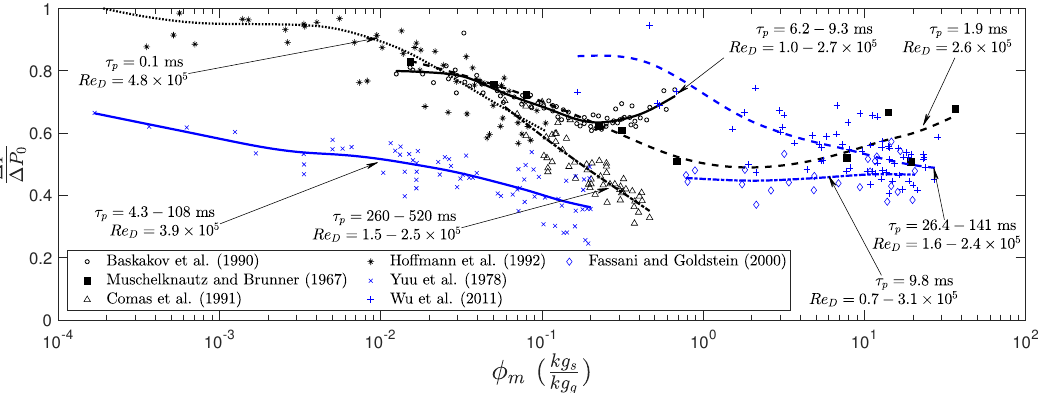
Figure 3. Experimental data of pressure drop (normalized with the pressure drop of a particle-free cyclone, ∆ P 0 ) versus mass loading of pilot-scale cyclones from selected studies [7–9,29,31,32,37]. The lines are numerical fits to each set of experimental data. The Reynolds number is calculated based on the inlet velocity and the cyclone body